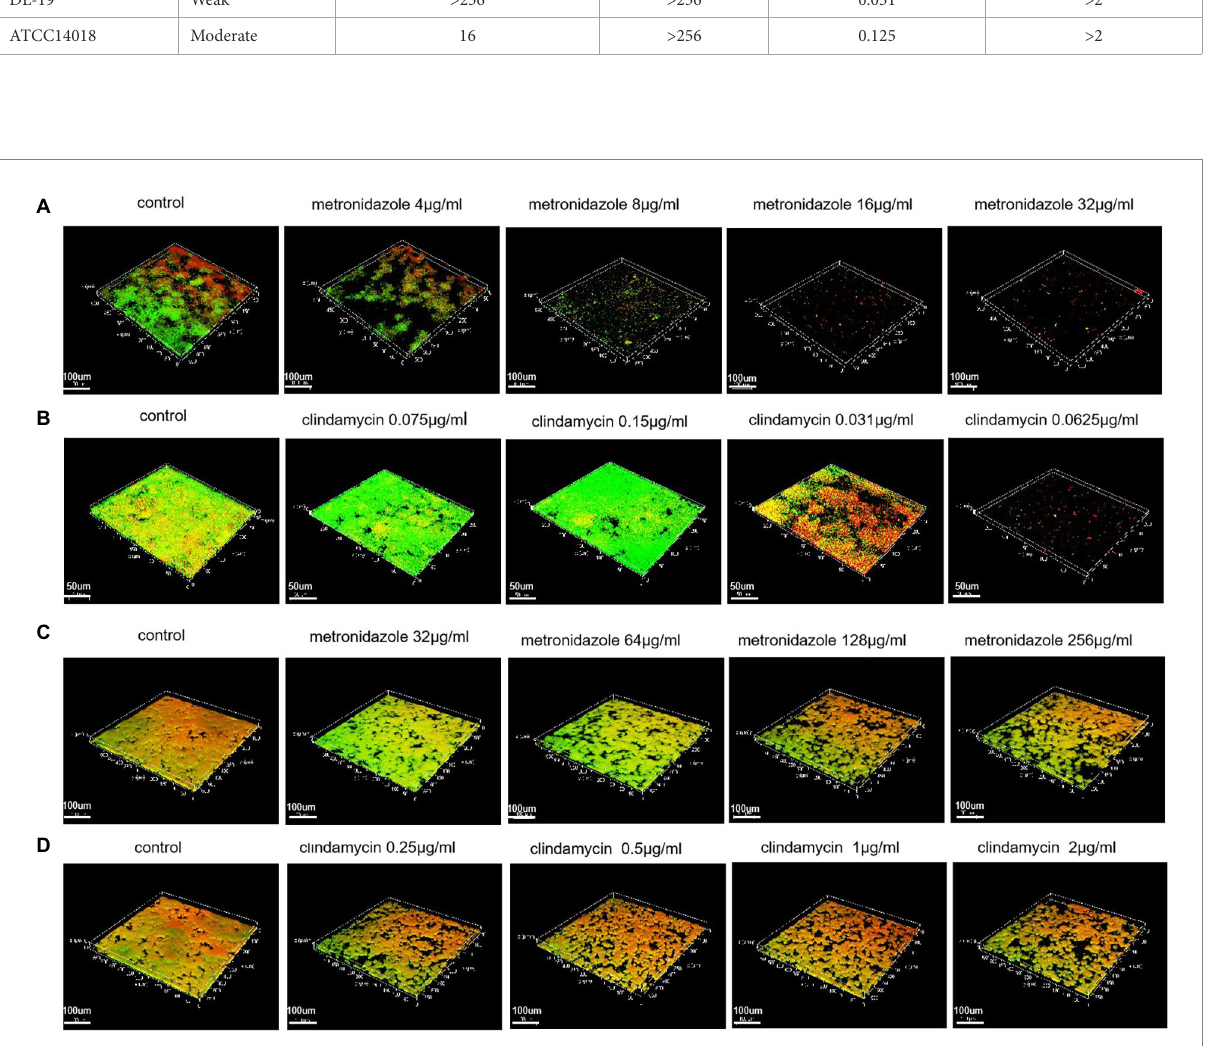
FIGURE 5 Biofilms inhibition and eradication detected with the Live/Dead® Viability Kit and CLSM. (A) Biofilms inhibition of ATCC 14018 at different metronidazole concentrations (control; 4 μ g/ml; 8 μ g/ml; 16 μ g/ml and 32 μ g/ml). (B) Biofilms inhibition of ATCC 14018 at different concentrations of clindamycin (control; 0.0075 μ g/ml; 0.015 μ g/ml; 0.031 μ g/ml and 0.0625 μ g/ml). (C) Biofilm eradication of ATCC 14018 under different concentrations of metronidazole (control; 32 μ g/ml; 64 μ g/ml; 128 μ g/ml and 256 μ g/ml). (D) Biofilm eradication of ATCC 14018 at different clindamycin concentrations (control; 0.25 μ g/ml; 0.5 μ g/ml; 1 μ g/ml and 2 μ